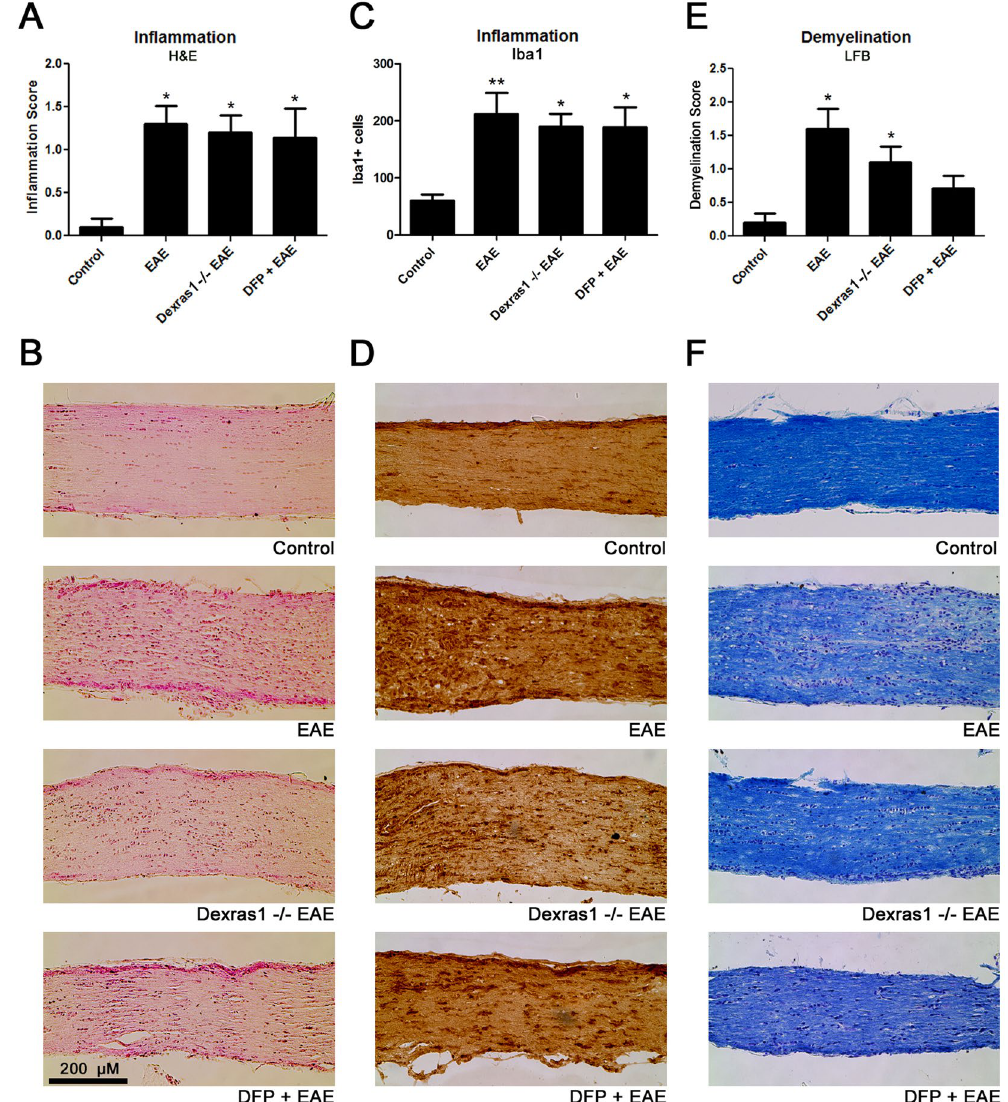
Figure 5. Dexras1 deletion or DFP treatment have no effect on optic nerve inflammation and just a trend towards effects on demyelination. To examine whether Dexras1 deletion or iron chelation prevents inflammation or demyelination, optic nerves were isolated from mice 42 days post immunization. ( A ) Inflammation quantified on a relative scale in H&E-stained optic nerve longitudinal sections shows optic nerves (N = 10 nerves) from EAE mice had significantly ( * p < 0.05) higher inflammation scores compared to optic nerves (N = 10) from control mice. Optic nerves from Dexras1 − / − EAE mice (N = 10 nerves) or DFP-treated EAE mice (N = 7 nerves) show no change in inflammation score compared to wild-type EAE mice. ( B ) A representative image of one optic nerve from a control, wild-type EAE, Dexras1 − / − EAE and DFP-treated EAE mouse. Sections show increased numbers of cells, representative of inflammatory cell infiltration, except within the optic nerve from a control mouse (original magnification × 20). ( C ) To further evaluate inflammatory cell infiltration by macrophages/microglia, optic nerves were immunostained using anti-Iba1 antibodies, and the number of Iba1 + cells counted per nerve is shown. Optic nerves from EAE mice (N = 10 nerves) have more Iba1 + cells than control mouse optic nerves (N = 10, * p < 0.05), and microglia/macrophage numbers are not reduced in optic nerves from Dexras1 − / − EAE (N = 10 nerves) or DFP-treated (N = 7 nerves) EAE mice. ( D ) Images show Iba1 + cells (brown) in one representative optic nerve from each group (original magnification × 20). ( E ) LFB-stained optic nerve longitudinal sections were used to quantify demyelination. Optic nerves (N = 10 nerves) from EAE mice had a significantly ( * p < 0.05) higher demyelination score than optic nerves (N = 10) from control mice. Demyelination scores of Dexras1 − / − EAE mice (N = 10 nerves) and DFP-treated (N = 7 nerves) EAE mice optic nerves show a trend toward less demyelination but no significant difference compared to wild-type EAE mice; however, only Dexras1 − / − EAE mice ( * p < 0.05) and not DFP-treated mice had increased demyelination compared with optic nerves from control mice. ( F ) A representative image of LFB staining in one optic nerve from each group (original magnification × 20) is